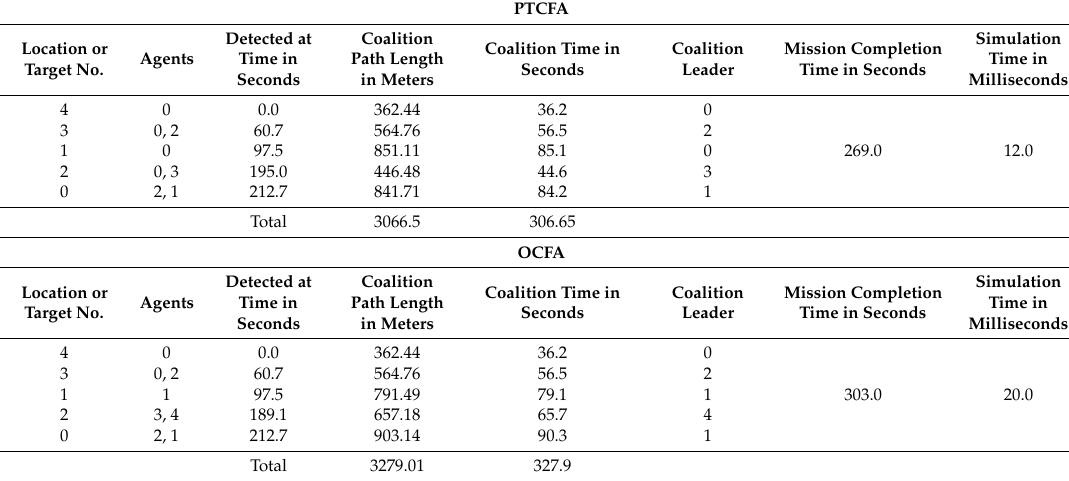
Table 2. Comparison of a single execution between PTCFA and OCFA for 5 targets/locations and 5 UAVs.